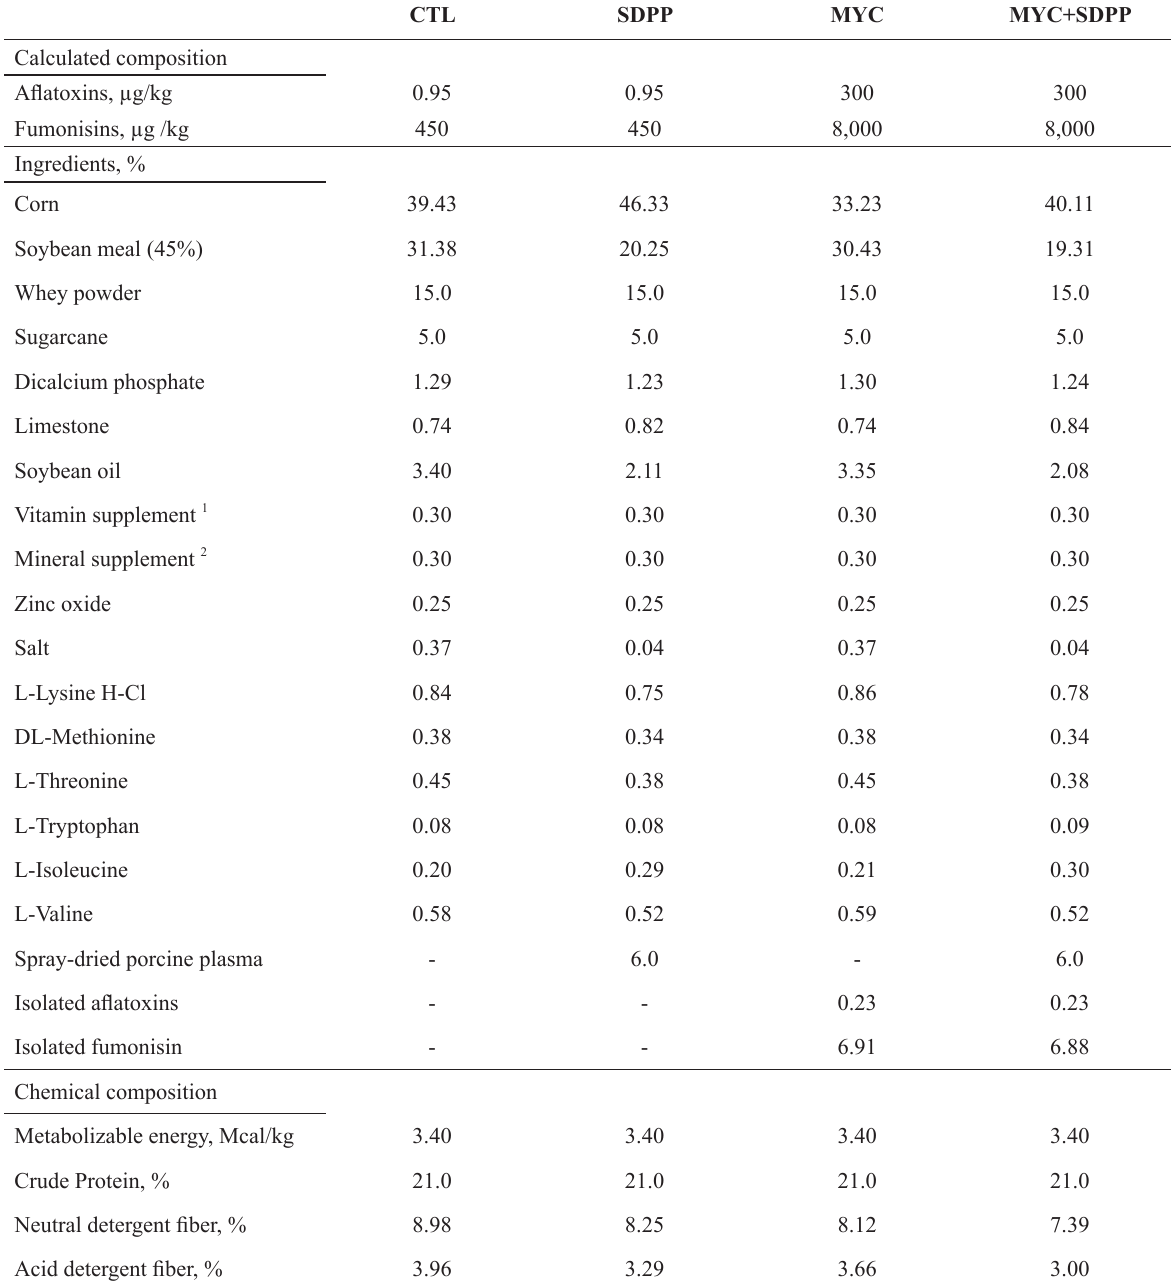
Composition of experimental diets. Adapted table of Muller et al. (2017). CTL: control diet; SDPP: control diet